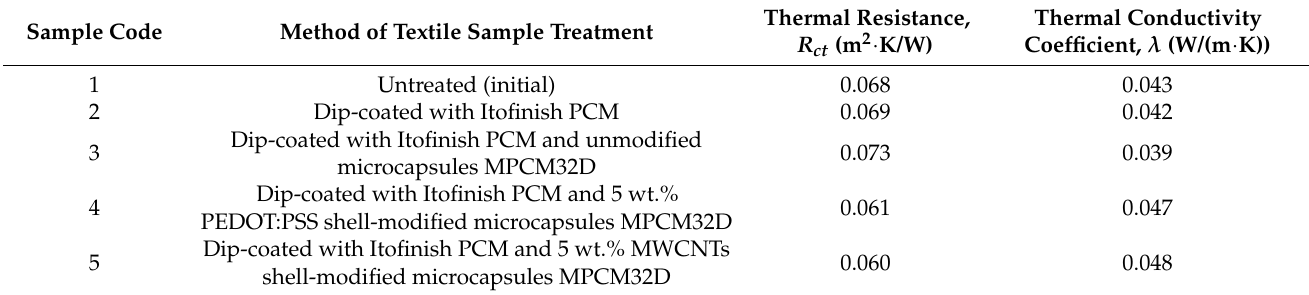
Table 4. Thermal properties of 3D warp-knitted spacer PET fabric untreated and dip-coated with microcapsules MPCM32D. Sample Code